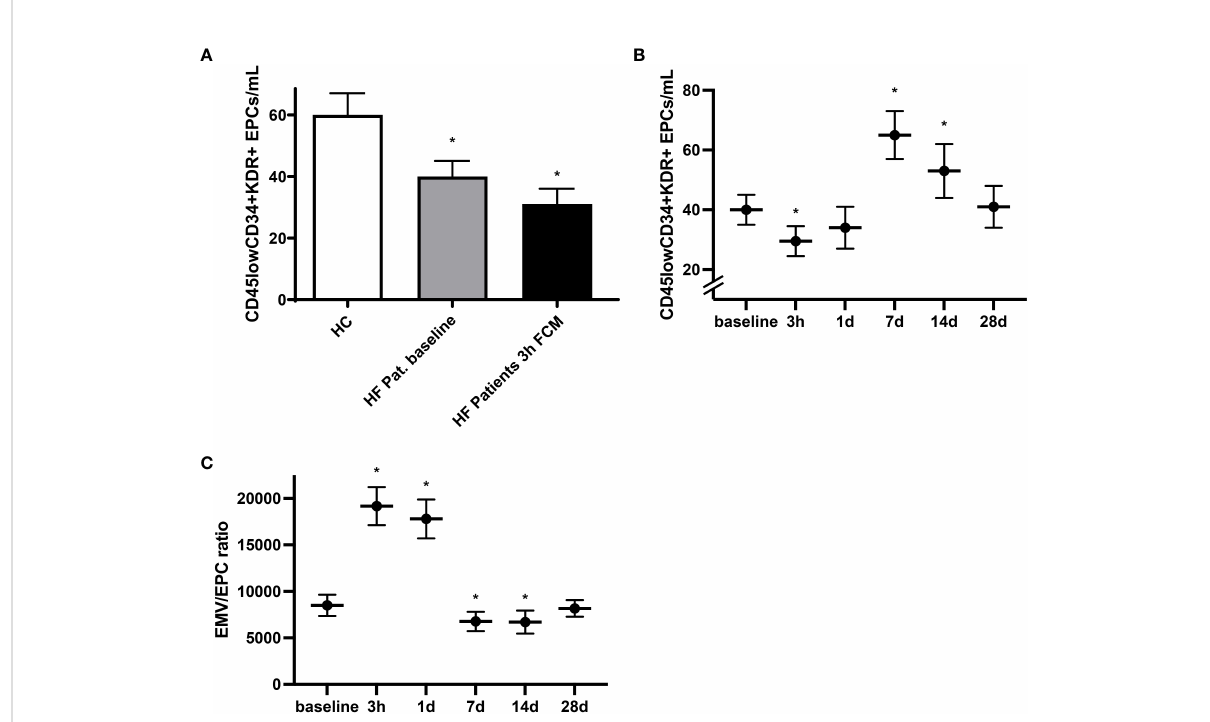
FIGURE 3 Mobilization of circulating EPCs following FCM application. (A) Levels of circulating CD45 low CD34 + KDR + EPCs in healthy controls and HF patients at baseline and three hours after FCM application as assessed by fl ow cytometry. *p < 0.05 vs. healthy controls. (B) Time course analysis of CD45 low CD34 + KDR + EPCs in HF patients at baseline and following FCM exposure. *p < 0.05 vs. baseline. (C) Time course analysis of EMV/ EPC ratio in HF patients. *p < 0.05 vs.